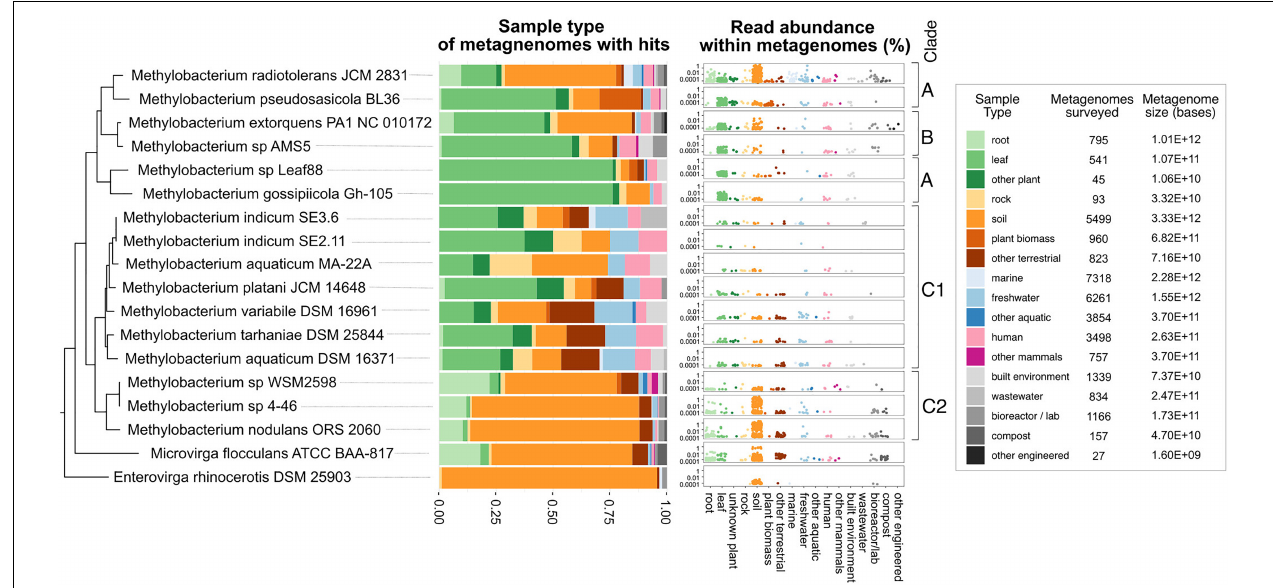
FIGURE 8 | Methylobacterium strains vary substantially in their distribution among ecosystems; not all strains are phyllosphere-associated. Published reads from 33,967 metagenomes were surveyed for BLAST hits with 90% or greater similarity to the genomes of 18 strains from the Methylobacteriaceae , using the Phylogenetic Distribution of Genes in Metagenome tool in IMG. Each metagenome was classified into one of 17 ecological sample types. For each strain, the barplot shows the distribution of BLAST hits among those sample types. In the dotplots, each dot represents one metagenome, with height indicating the abundance of reads matching the strain’s genome within that metagenome. Points are color-coded, and clustered along the x -axis, by sample type. For context, the number of metagenomes, and total number of bases surveyed (in all metagenomes) is provided for each sample type. Phylogeny of the rpoB gene of the target species (as in Supplementary Figure 2 ) is shown at